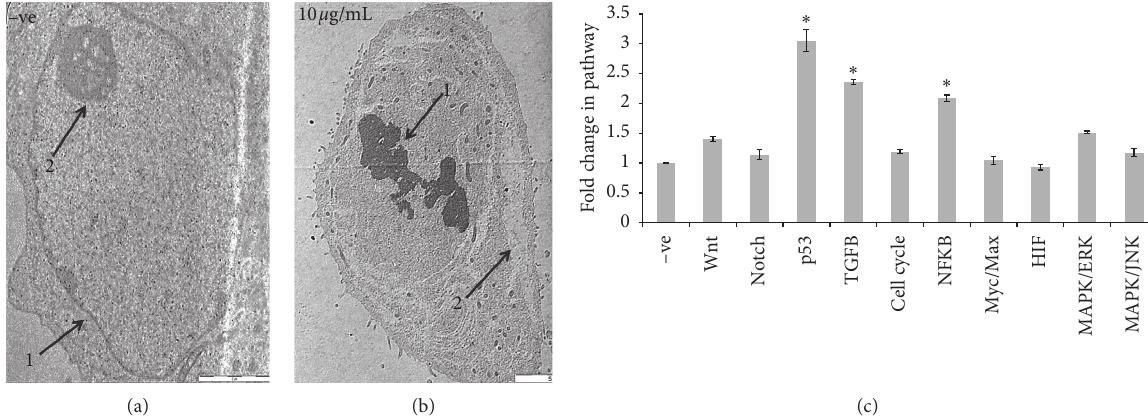
Figure 2: (a) TEM ultrastructural micrograph of untreated MCF-7 cells.1. Nucleus. 2. Nucleolus. Magnification is 1600x. (b) Ultrastructural micrograph of MCF-7 cell after treatment by EHX (10 μ g/mL).1: chromatin condensation; 2: vacuoles. Magnification is 1250x. (c) The effect of EHX (10 μ g/mL) on 10 signaling pathway activities. Values are mean ± SD. ∗ p <